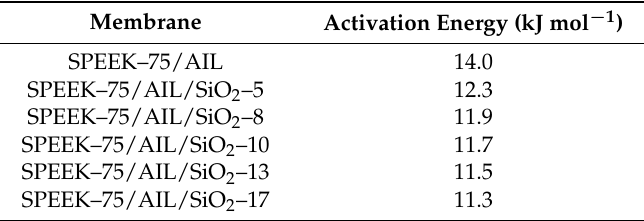
Table 1. The activation energy for proton conduction through SPEEK/AIL/SiO 2 composite